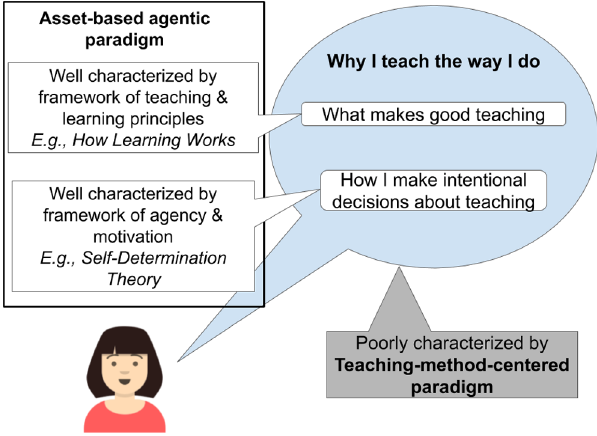
FIG. 1. Faculty talking about why they teach the way they do can be well characterized by frameworks of principles of teaching and learning, and agency and motivation, while a framework centering teaching methods tends to miss key